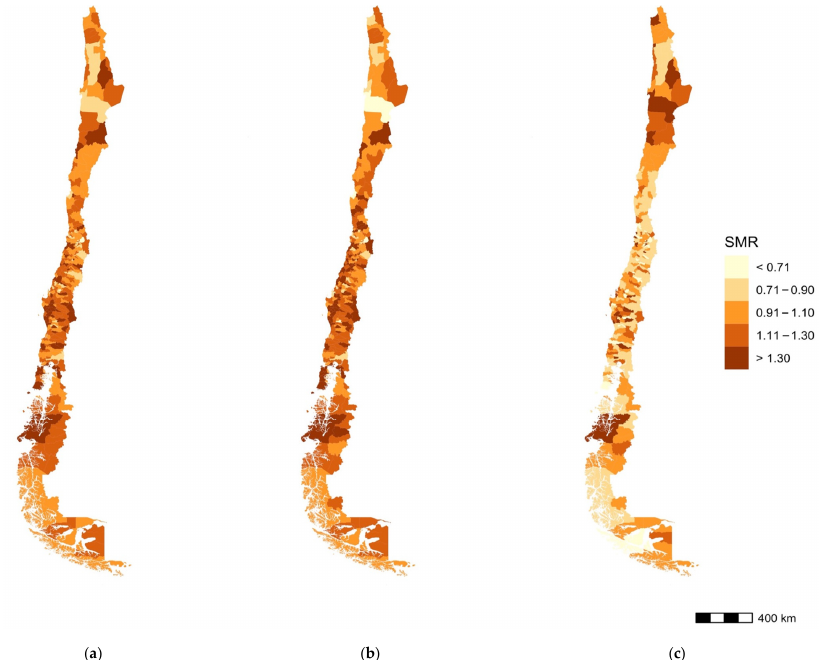
Figure 2. Smoothed Standardized Mortality Ratios (SMR) for ( a ) total deaths, ( b ) suicides and ( c ) homicides, 2016–2018. Table 4. Municipal level correlated for suicide and homicides in Chile, 2016–2018.